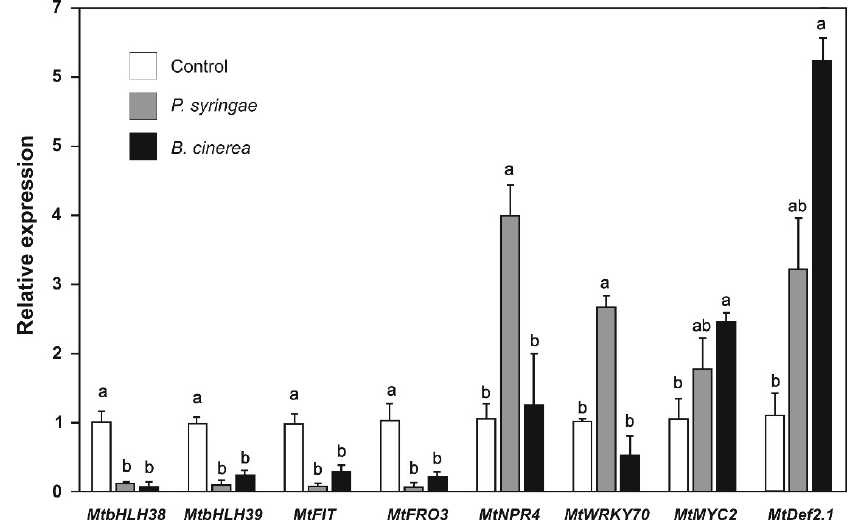
Figure 9. Relative expression of iron uptake and defense genes in Medicago truncatula plants inoculated with Pseudomonas syringae or Botrytis cinerea . Values represent mean ± standard errors of